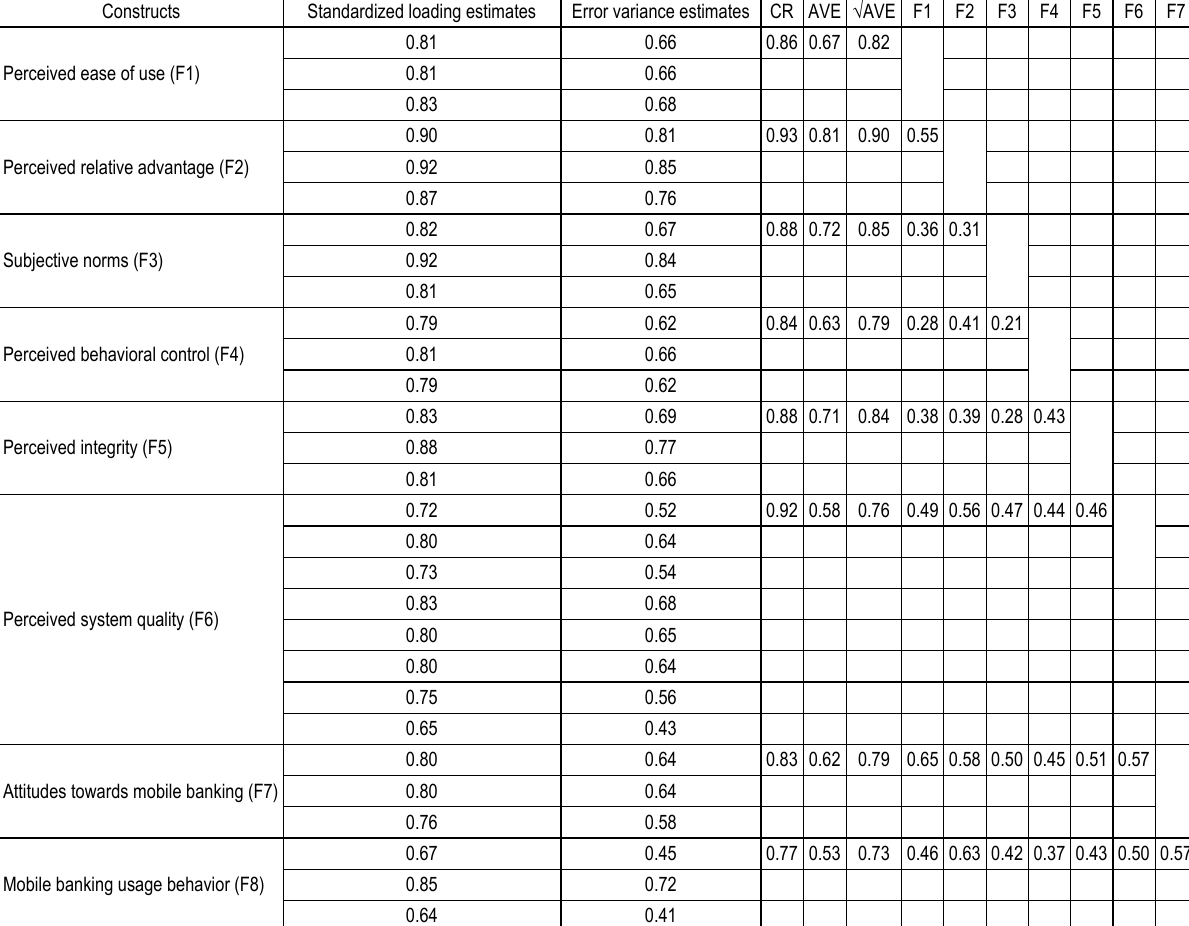
Table 4. Measurement model estimates, construct reliability and validity, and correlation coefficients